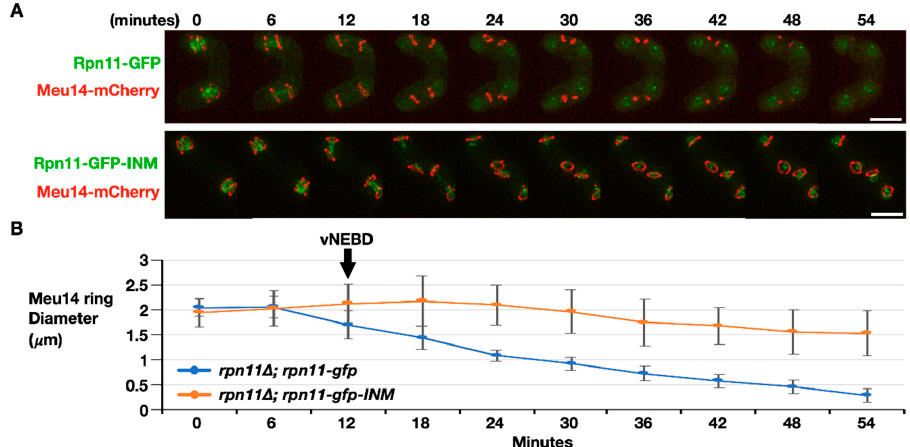
Figure 5. FSM closure is defective in the rpn11-gfp- INM cells. ( A ) Representative time-lapse images of FSM closure monitored by dynamics of Meu14-mCherry in the rpn11 Δ cells expressing Rpn11-GFP (upper panel) or Rpn11-GFP-INM (lower panel). Scale bar: 5 µm. ( B ) Quantification of the Meu14 ring diameter over the time course. At least 30 of the Meu14 rings were tracked and quantified at the indicated time points for each strain. ImageJ was used for quantification. The black arrow indicates the onset of anaphase II when the vNEBD occurs.